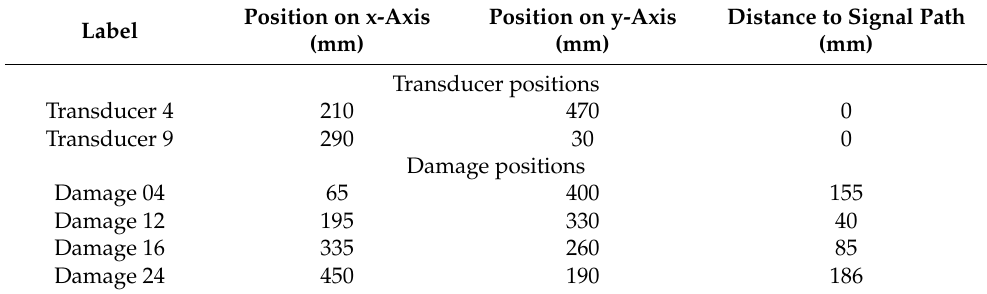
Table 1. Position of the transducers and the damage locations [12]. The distance of the damage locations to the direct signal path had been